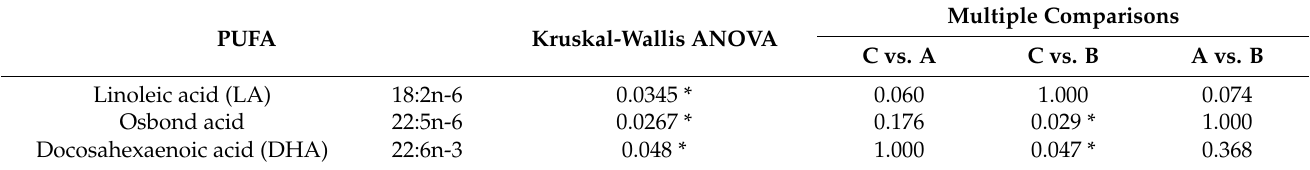
Table 3. Significant changes in PUFAs in plasma triacylglycerols. The numbers represent the p